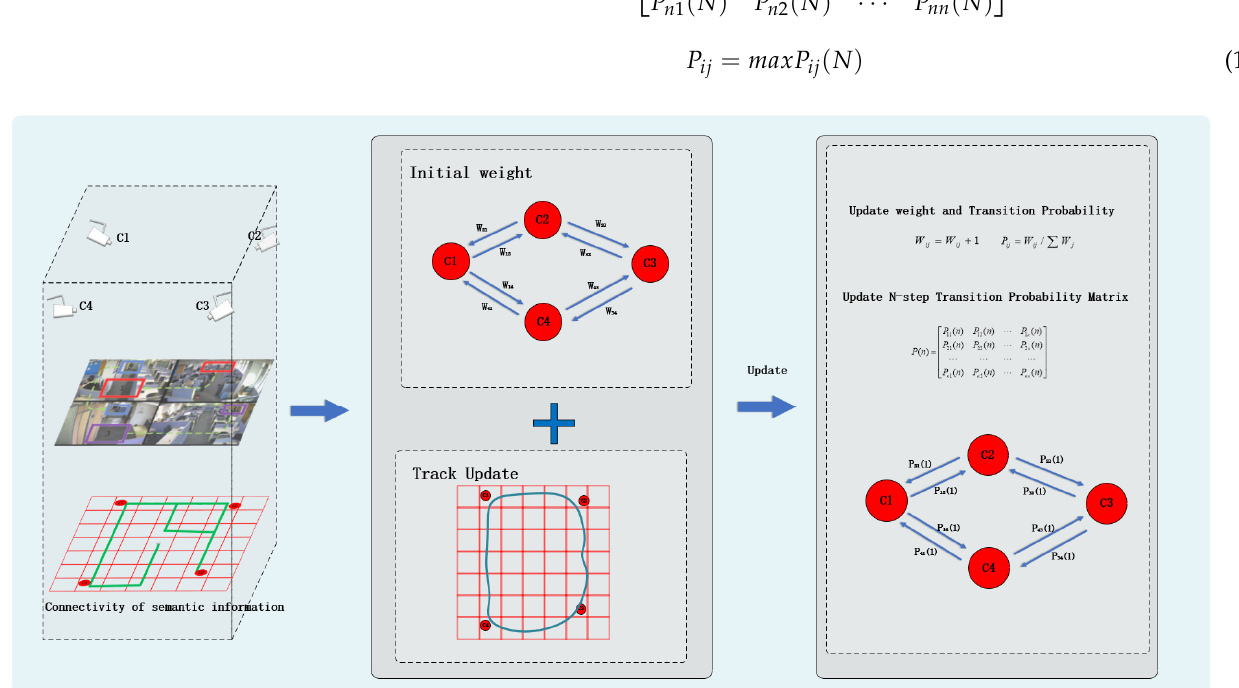
Figure 7. Semantic information on connectivity.